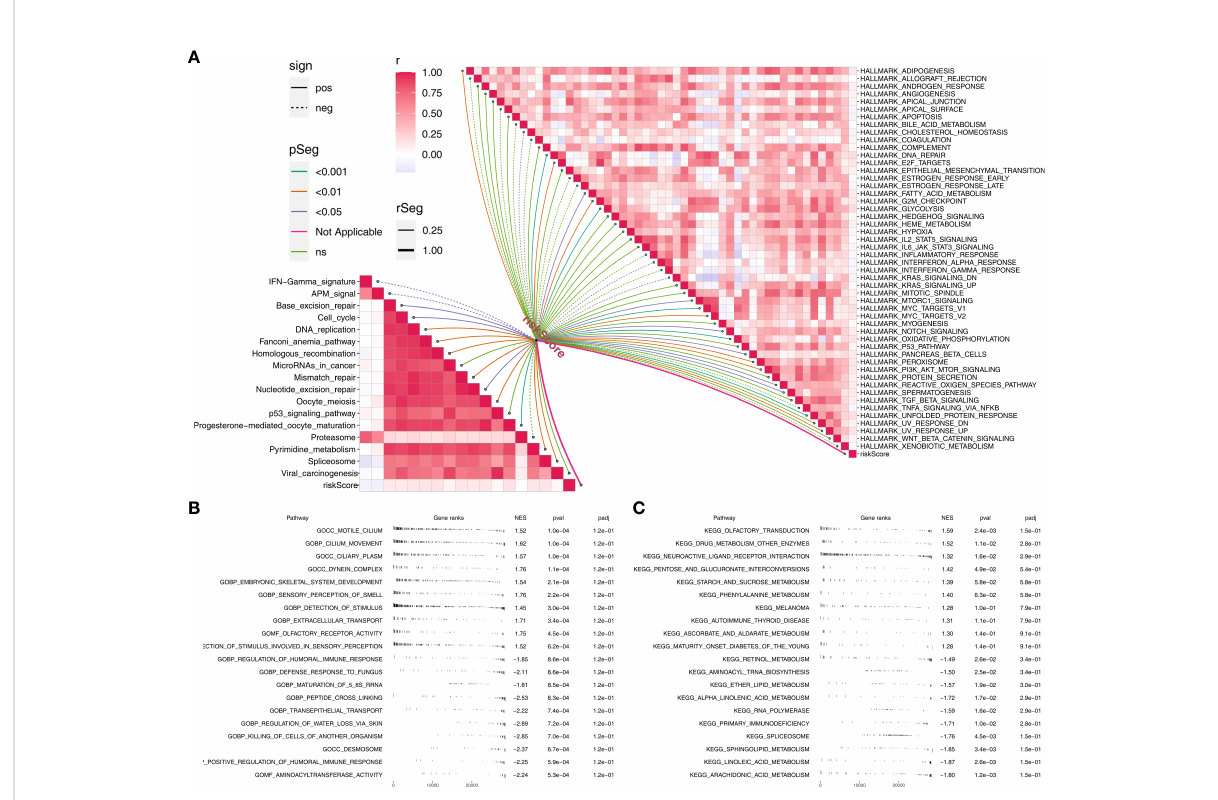
FIGURE 5 Pathway enrichment analysis. (A) The correlation of riskscore with immune and hallmark pathways; (B) GSEA analysis based on GO terms; C: GSEA analysis based on KEGG